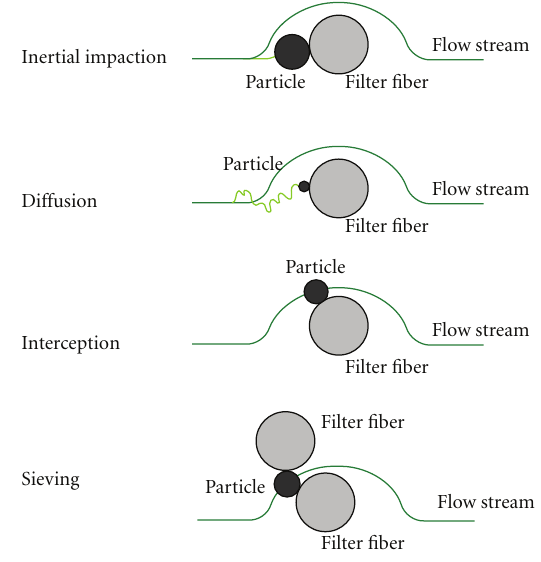
Figure 1: Common filtration mechanism